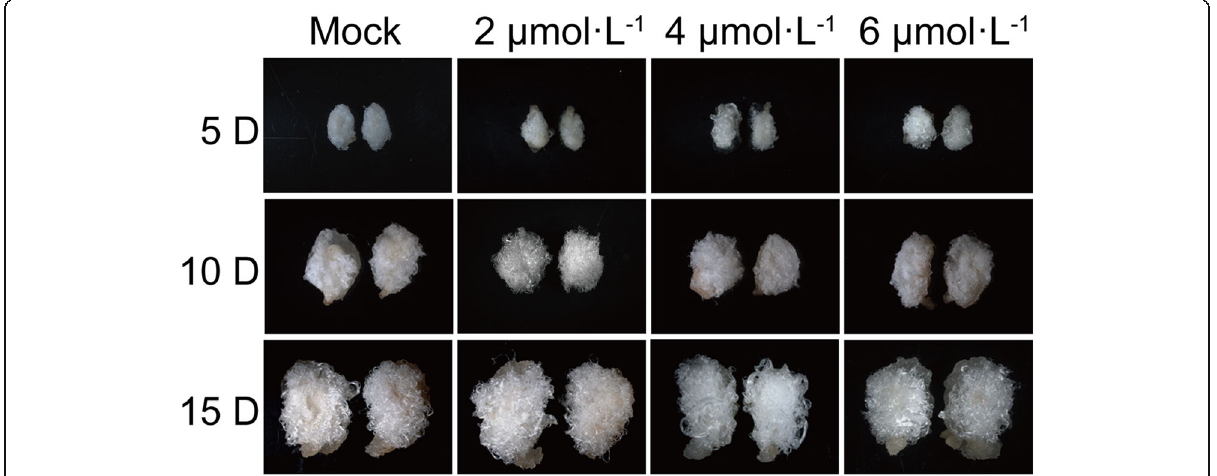
Fig. 1 Effects of di-4-ANEPPDHQ on the growth of cotton fiber cells. Cotton ovules were treated with 0 μ mol·L − 1 , 2 μ mol·L − 1 , 4 μ mol·L − 1 , 6 μ mol·L − 1 di-4-ANEPPDHQ and cultured in vitro for 5 day, 10 day and 15